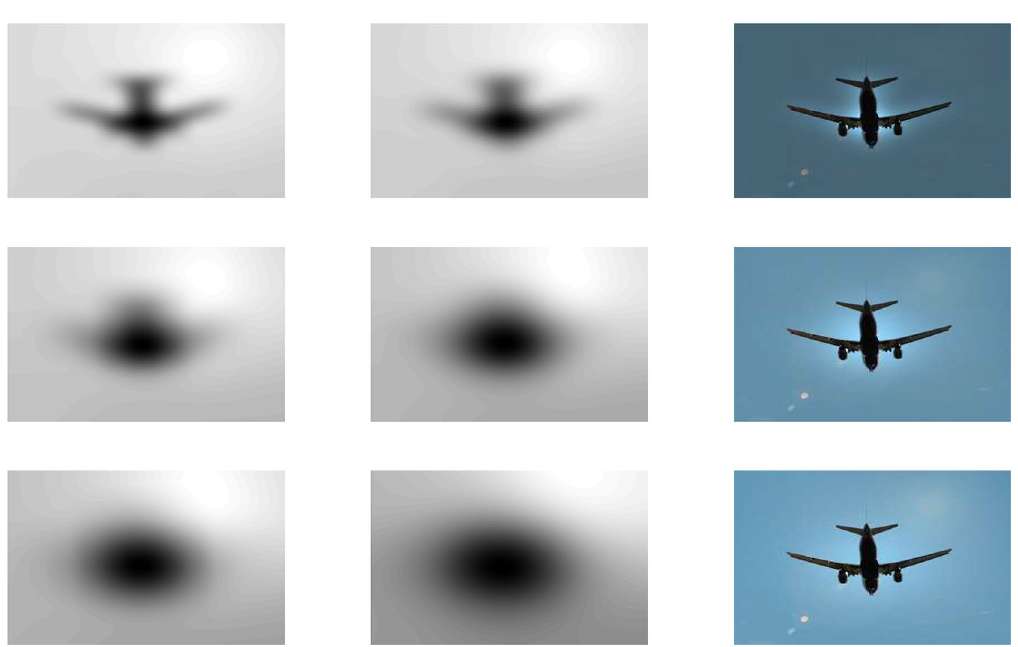
Figure 3. A demonstration of the dual filter formulation on color image of plane having high brightness in background, with different values of k . The first column shows the inhomogeneity covered by first filter, the second column shows the inhomogeneity covered by the second filter, and the last column demonstrates the inhomogeneity-free images. The first row deliberates the outcomes for k = 10 , the second row deliberates the outcomes for k = 20 , and the last row demonstrates the obtained results for k = 30 . These inhomogeneous images datasets are collected from the Goldstein et al. 6 , Cai et al. 14 and are publicly available at the kaggle repository 33